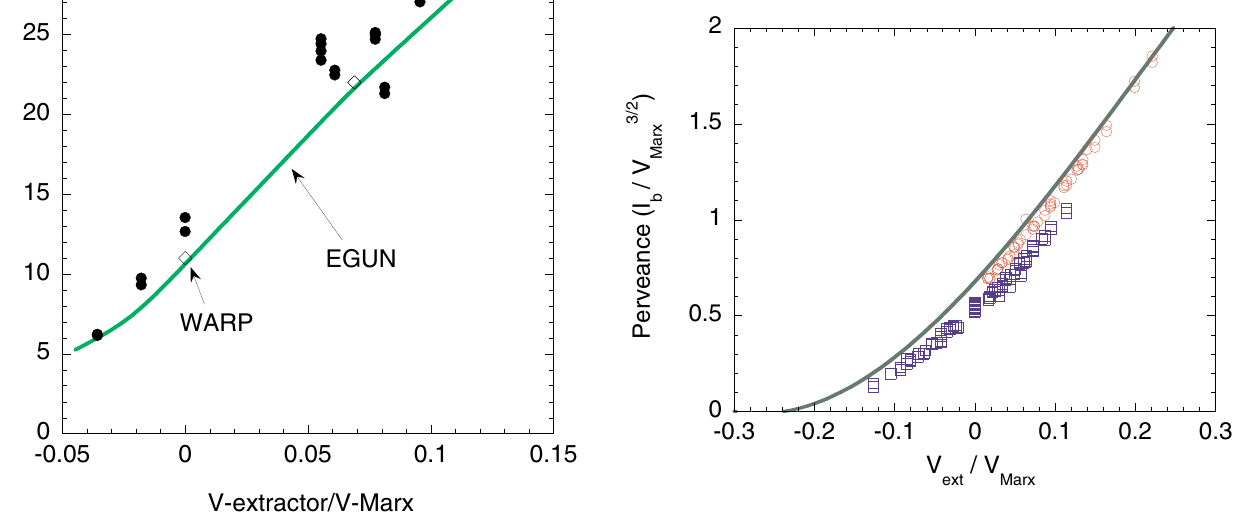
FIG. 9. (Color) Comparison of the 2-rms beam size (solid circles) measured at 2.5 cm downstream of the extraction elec- trode with EGUN (curve) and WARP (open diamonds) results as a function of the ratio of extraction voltage to Marx voltage.